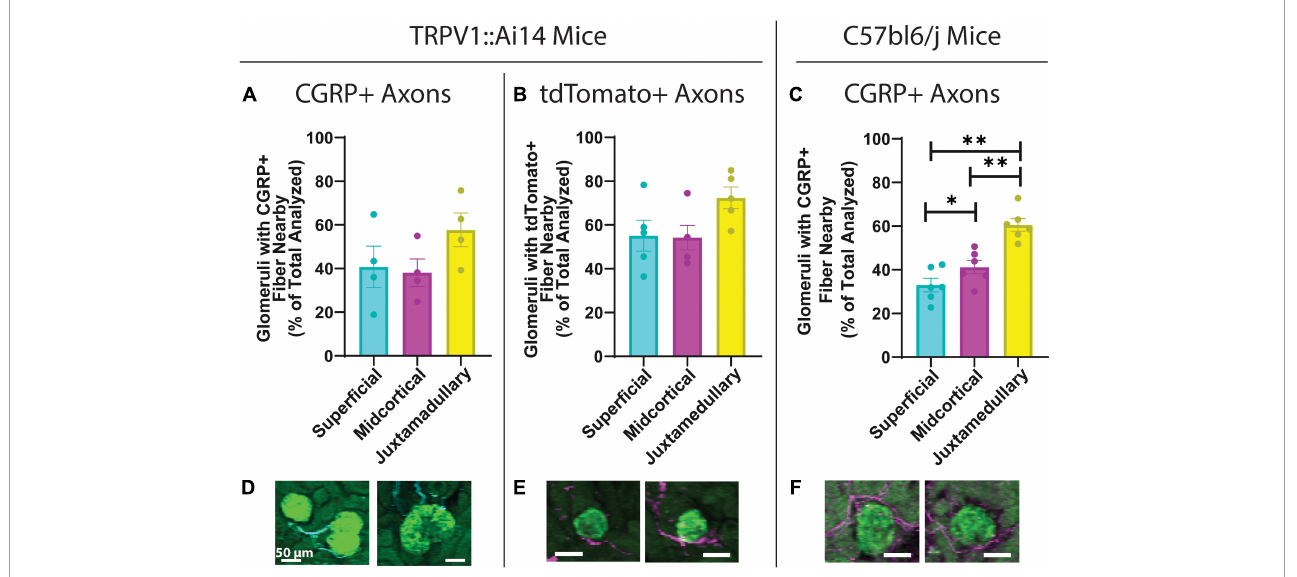
FIGURE2 Quantitative analysis of the anatomical relationship between afferent axons and glomeruli in TRPV1:Ai14 and wildtype C57BL/6J mice. (A) Prevalence of calcitonin gene related peptide (CGRP)+ afferent axons near glomeruli in TRPV1:Ai14 mice ( n = 4), presented by glomerular category based on depth within the cortex. Glomeruli at all depths were found to have similar frequencies of anatomical interactions with CGRP+ axons in TRPV1:Ai14 mice (Superficial: 40.78 ± 9.50%, Midcortical: 38.09 ± 6.29%, Juxtamedullary: 57.74 ± 7.70%; total number of evaluated glomeruli: 1346, 1 slice per animal). (B) Prevalence of tdTomato+ afferent axons near glomeruli in TRPV1:Ai14 mice ( n = 5), presented by glomerular category based on depth within the cortex. Glomeruli at all depth categories were found to have similar frequencies of anatomical interactions with tdTomato+ axons in TRPV1:Ai14 mice (Superficial: 55.14 ± 7.06%, Midcortical: 54.22 ± 5.59%, Juxtamedullary: 72.40 ± 4.98%; total number of evaluated glomeruli: 1476, 1 slice per animal). (C) Prevalence of CGRP+ afferent axons near glomeruli in wildtype C57bl6/j mice ( n = 6), presented by glomerular category based on depth within the cortex. Deeper glomeruli had closely apposed CGRP+ axon bundles more frequently than more superficial glomeruli (Superficial: 33.00 ± 3.11%, Midcortical: 41.22 ± 3.05%, Juxtamedullary: 60.57 ± 2.90%; total number of evaluated glomeruli: 3532, 1 slice per animal). (D–F) Examples of anatomical relationships between CGRP+ axons and glomeruli in TRPV1:Ai14 mice (D) , tdTomato+ axons and glomeruli in TRPV1:Ai14 mice (E) , and CGRP+ axons and glomeruli in C57bl6/j wildtype mice (F) as presented while scoring individual glomeruli (scale bars: 50 µ m). (Mean ± SEM, ∗ p < 0.05, ∗∗ p < 0.01